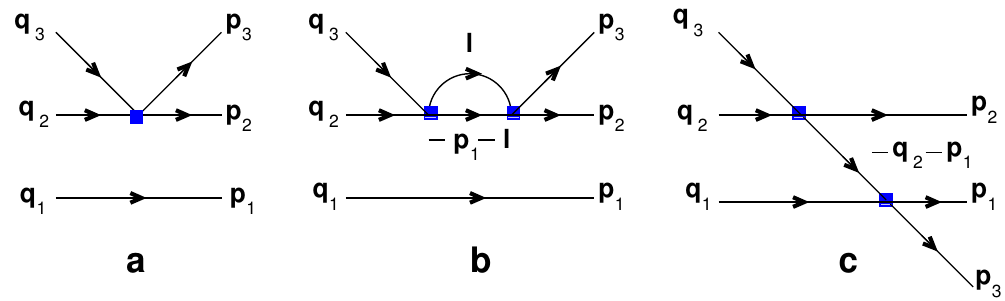
Figure 2 . Lowest-order Feynman graphs emerging in the expansion of the quantity (cid:23)